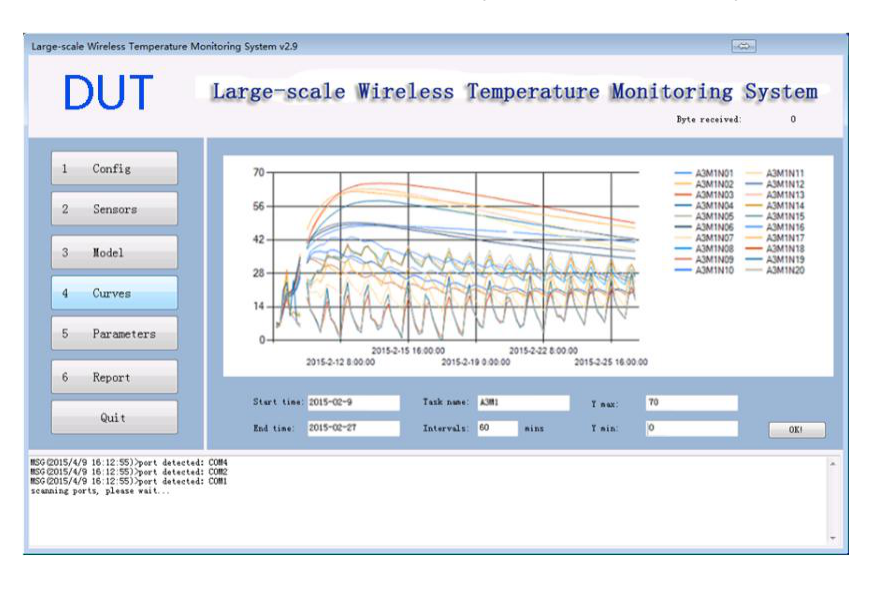
Figure 15. Curve Module.